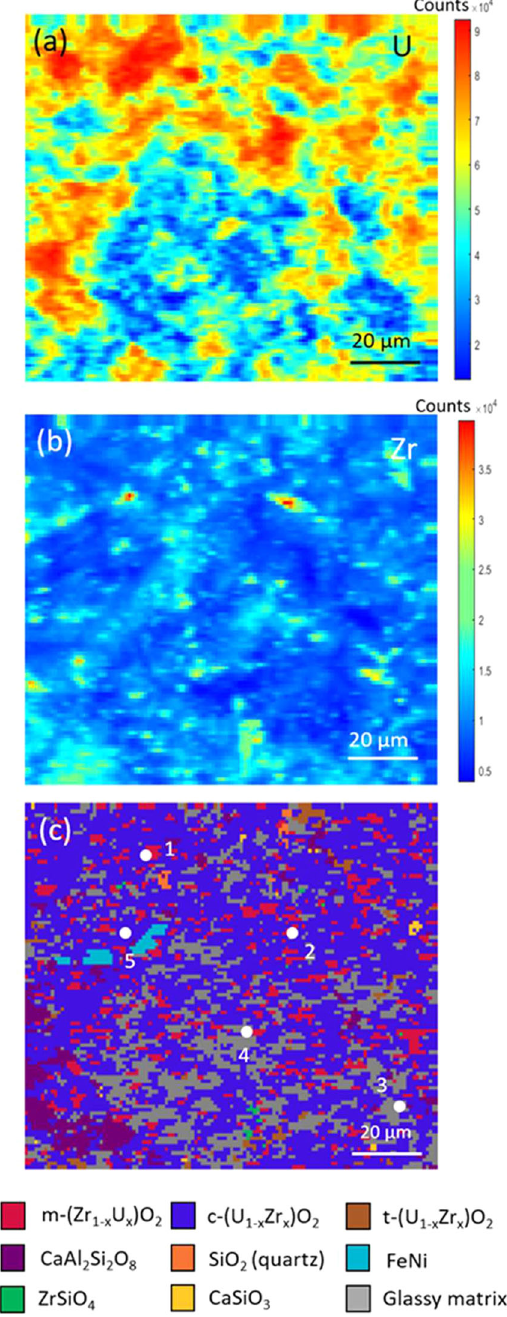
Fig. 3 Micro-focus X-ray analysis of MCCI-1. Showing distribution of a U-L α and b Zr-K α X-ray fl uorescence signals; and c 2D µ- diffraction map reconstructed from µ-XRD patterns taken at each pixel in the µ-XRF maps shown in a and b . The individual XRD patterns are shown in Fig. 6 and Supplementary Figs. 3 and 4. The white points labelled 1 – 5 in c indicate the locations of interest that XANES spectra were collected from, detailed in Fig. 7. Scale bar on all images is 20